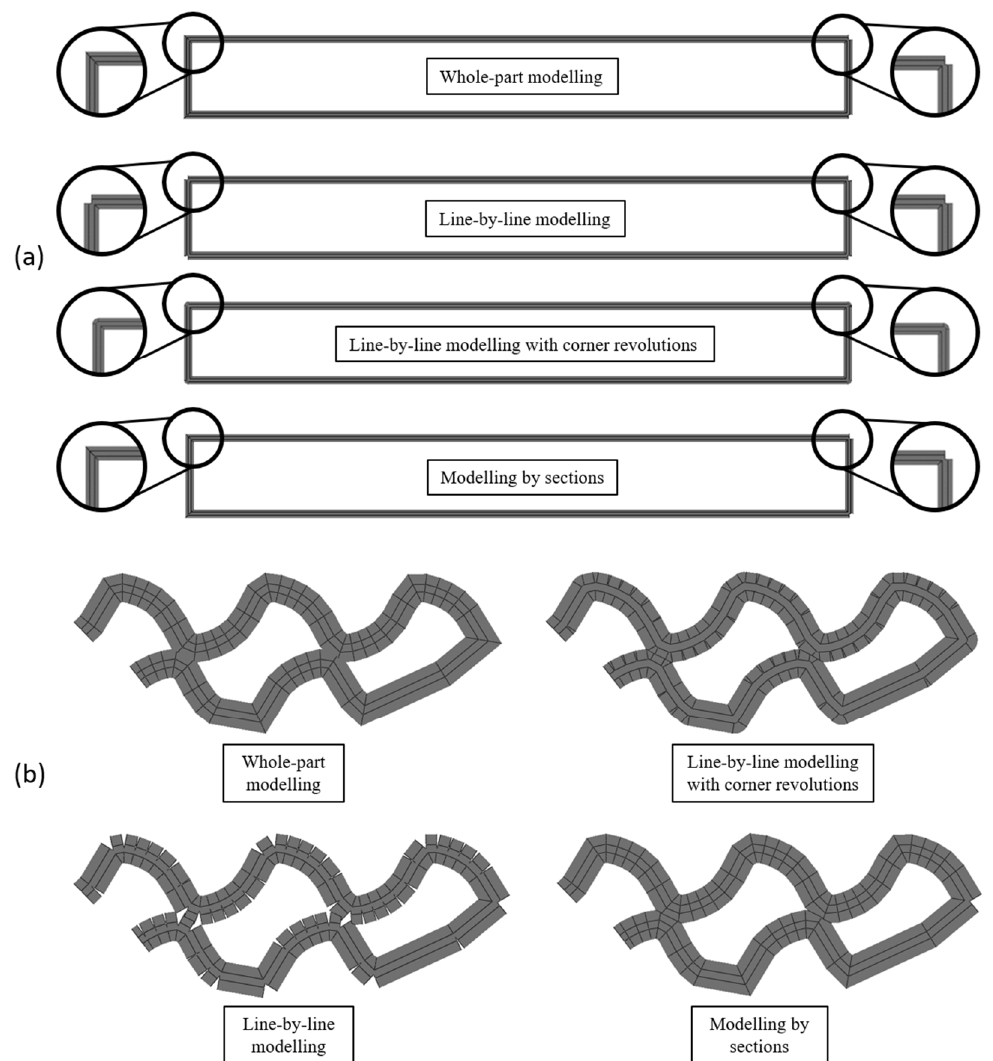
Figure 10. Comparison of modelling strategies in simple parts ( a ) and complex parts ( b ).